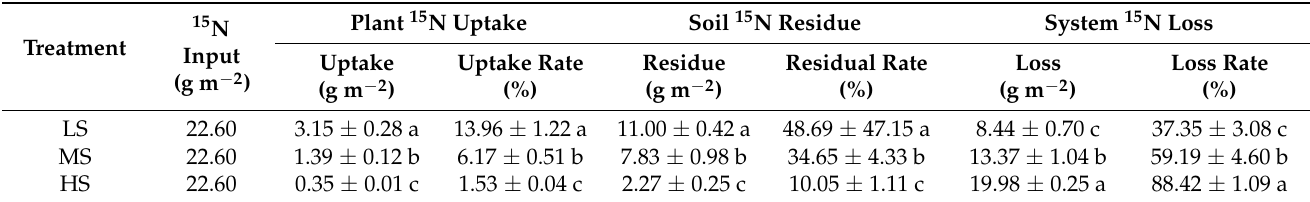
Table 4. Balance of 15 N fate in soil-wheat systems of different saline soils